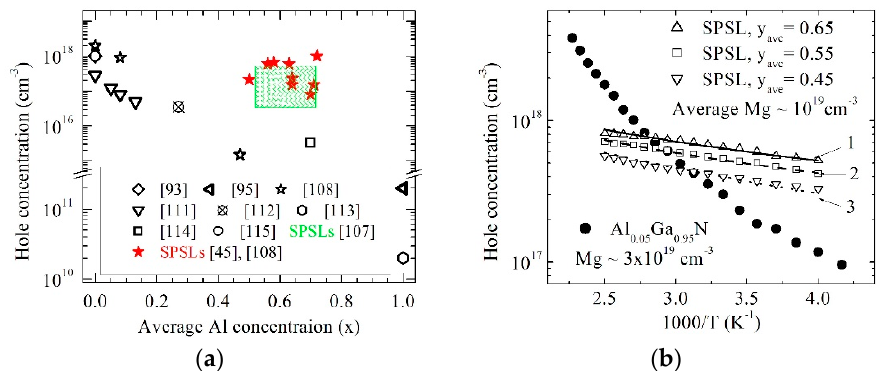
Figure 6. Hole concentration in Al x Ga 1-x N alloys and AlN/AlGa(In)N SPSLs. ( a ) The dependence on average Al concentration in epitaxial layers (black symbols) and in SPSLs (red symbols and green box); ( b ) The temperature dependence of the hole concentration in Al 0.05 Ga 0.95 N epitaxial layer (~0.5 μ m thick, filled circles) and in AlN/Al x Ga 1 − x N SPSLs (open symbols). Lines 1, 2, and 3 are the results of the applied BESST simulator [76].